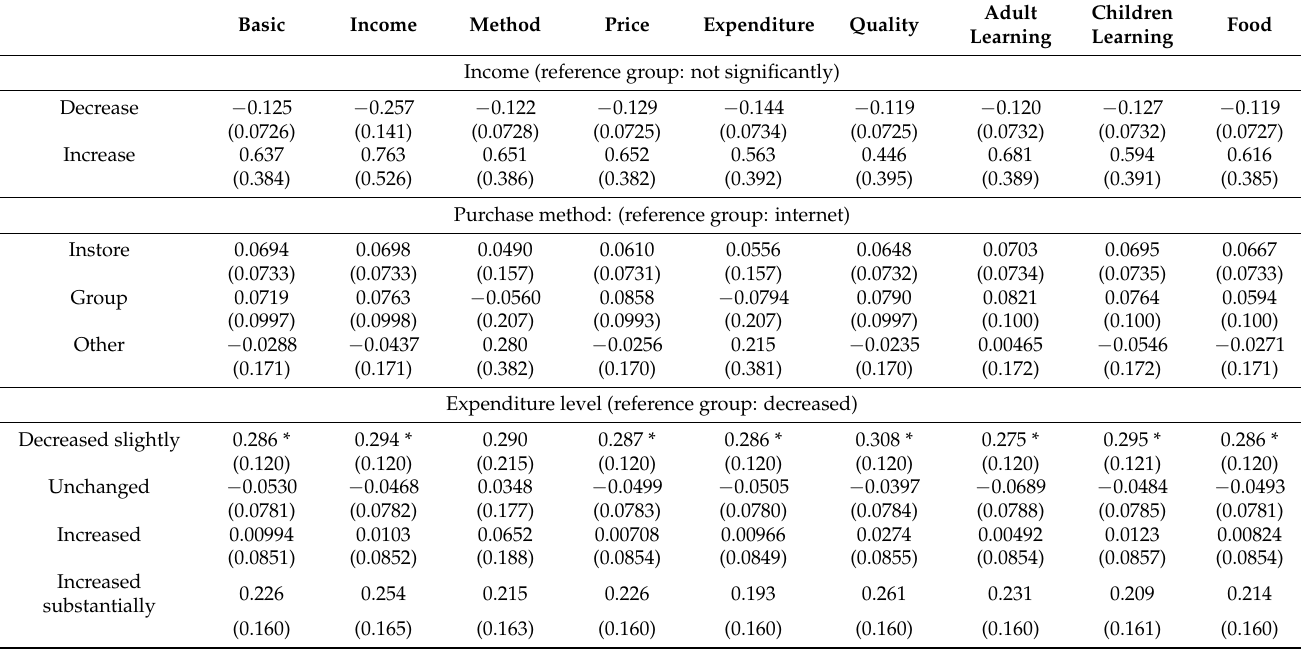
Table 3. Independent effect of core variables on